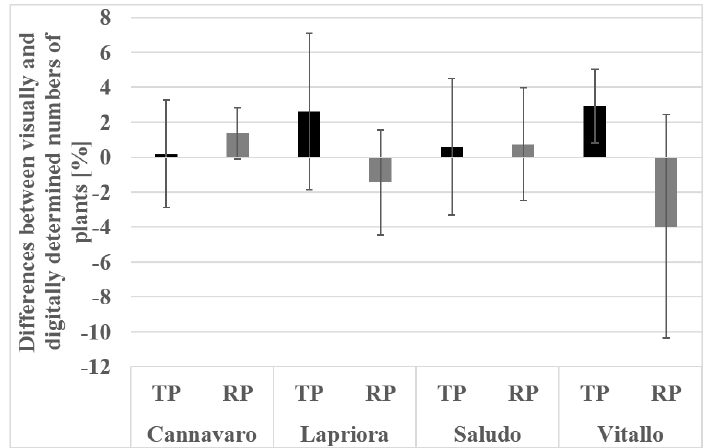
Figure 11. Bar chart illustrating the mean of the percentage differences between visually and digitally determined numbers of four cultivars in triangular planting (TP) and row planting (RP) systems. The percentage difference is calculated as: (digitally measured plant number—visually counted plant number)/visually counted plant number × 100.